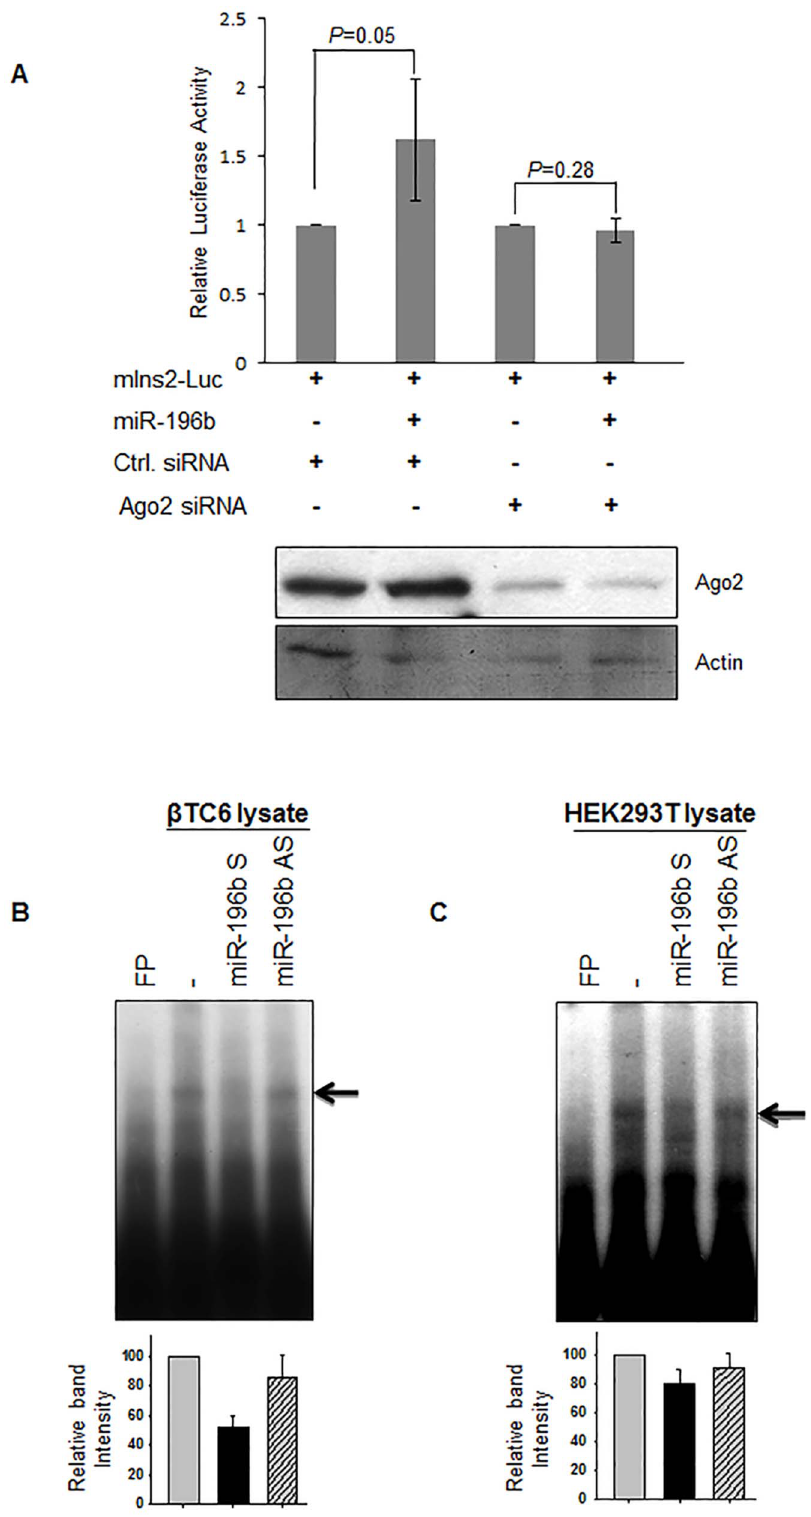
Figure 3. miR-196b requires Ago2 for translation activation of the target mRNA. ( A ) Reporter insulin2-Luc was cotransfected into HEK293T cells along with miR-196b, control siRNA or Ago2 siRNA. The fold change in relative luciferase activity was measured with the activity of the luciferase construct with control miRNA set to 1. Bottom , representative western blot to detect the levels of Ago2 and loading control b -Actin. The sample in each lane is indicated. ( B, C ) RNA-EMSA using the radiolabeled insulin2 RNA as probe and extracts from b TC6 (B) or HEK293T (C) cells. The arrow indicates the shifted RNP complexes. The lower panel shows the RNA-protein complex intensity as measured by densitometry. The graphs represent the means 6 SD of 3 independent experiments; P values (Student’s t-test) are indicated.